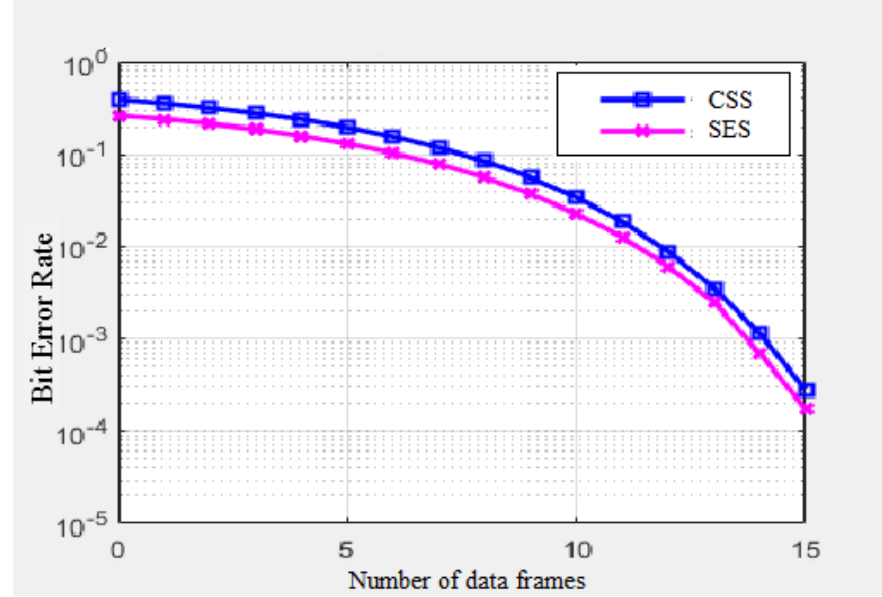
Figure 12. Bit error rate of SES vs. CSS.